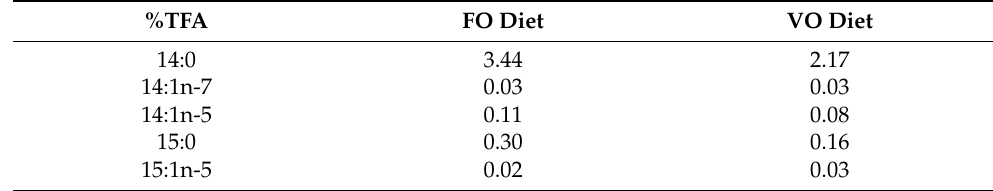
Table 3. Fatty acid profiles (% total fatty acids) of the fish oil (FO) and vegetable oil (VO) broodstock